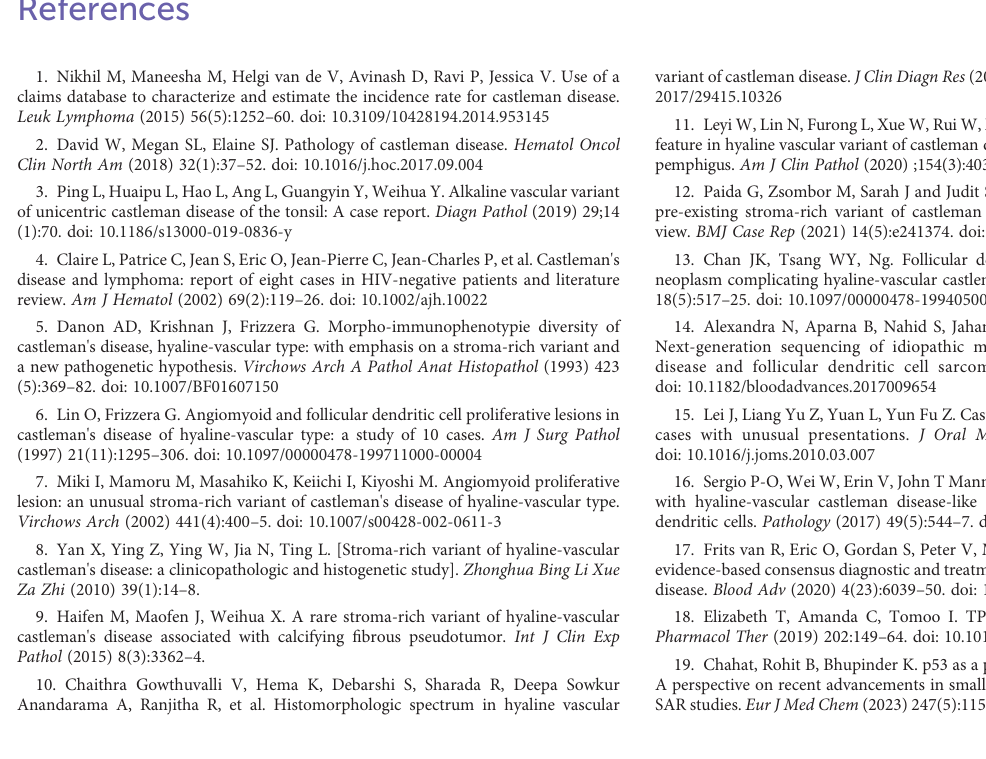
SUPPLEMENTARY FIGURE 1 Another fi eld demonstrates the morphologic transition of the spindle cells from mild morphology (left side of the dot line) to marked atypia (right side of the dot line) (A) . In the former region (the red square), the spindle cells exhibit vesicular to fi ne chromatin, and inconspicuous small nucleoli (B) . In contrast, the cells in the latter region (the yellow square) illustrate enlarged, irregular nuclei and atypical mitosis (white arrow) (C) . SUPPLEMENTARY FIGURE 2 The atypical spindle cells demonstrate the hemangiopericytoma-like arrangement (white arrow) and focal necrosis (black arrow). SUPPLEMENTARY FIGURE 3 Hyperplastic small vessels are intermixed with the compact atypical spindle cells. They are not easily detectable on H&E section, while could be highlighted by CD34 staining. SUPPLEMENTARY FIGURE 4 The atypical spindle cells show negative staining with CD21, CD23, CD35, SSTR2, D2-40, and CXCL13. SUPPLEMENTARY FIGURE 5 Magneticresonanceimagingshowsnodularabnormalsignals(whitearrow)in the liver, right paraspinal (A) and vertebral bodies (B)